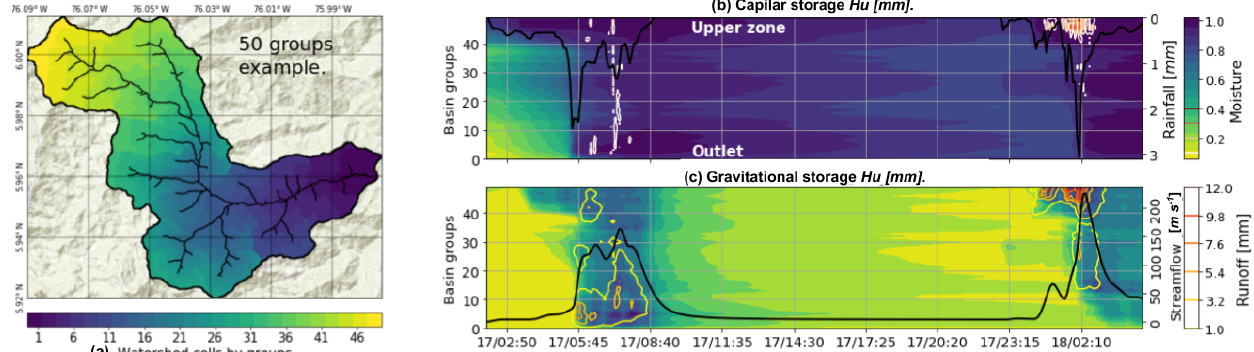
Figure 13. (a) Example of watershed grouping as a function of of their localization and distance to the outlet for La Liboriana basin using a 50-group categorization. (b) Simulated capillary moisture (filled green-to-blue contours) and returned flow occurrence (white to red isolines). The black line represents the average rainfall over the basin. (c) Simulated gravitational moisture (filled green-to-blue contours) and runoff (yellow-to-red isolines). The black line represents streamflow at the outlet of the basin. The green-to-blue color bar serves as a reference for capillary moisture and gravitational water